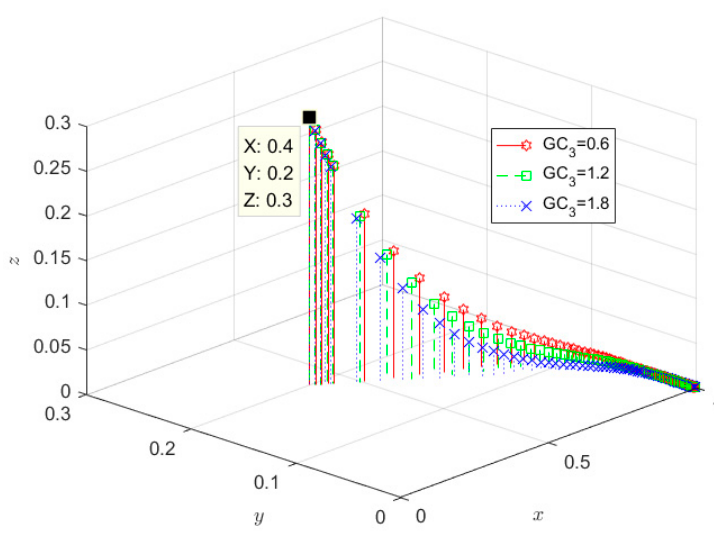
Figure 7. Impact of the cost of the government without any incentives.